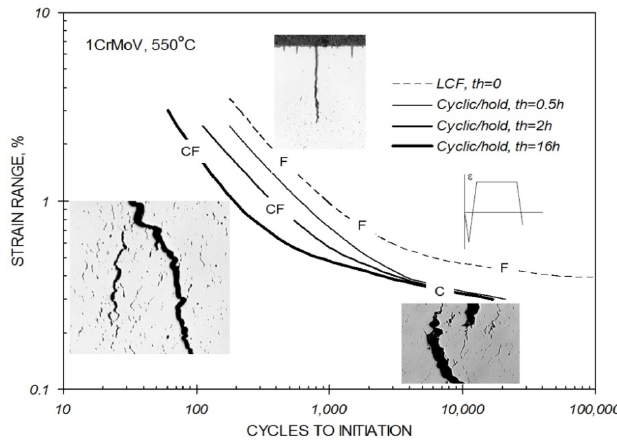
Figure 2. Influence of hold time on the cyclic/hold creep ‐ fatigue endurance of 1CrMoV steel at 550 °C where crack development is identified as being pure creep (C), pure fatigue (F) or creep ‐ fatigue (CF). LCF = Low Cycle Fatigue.